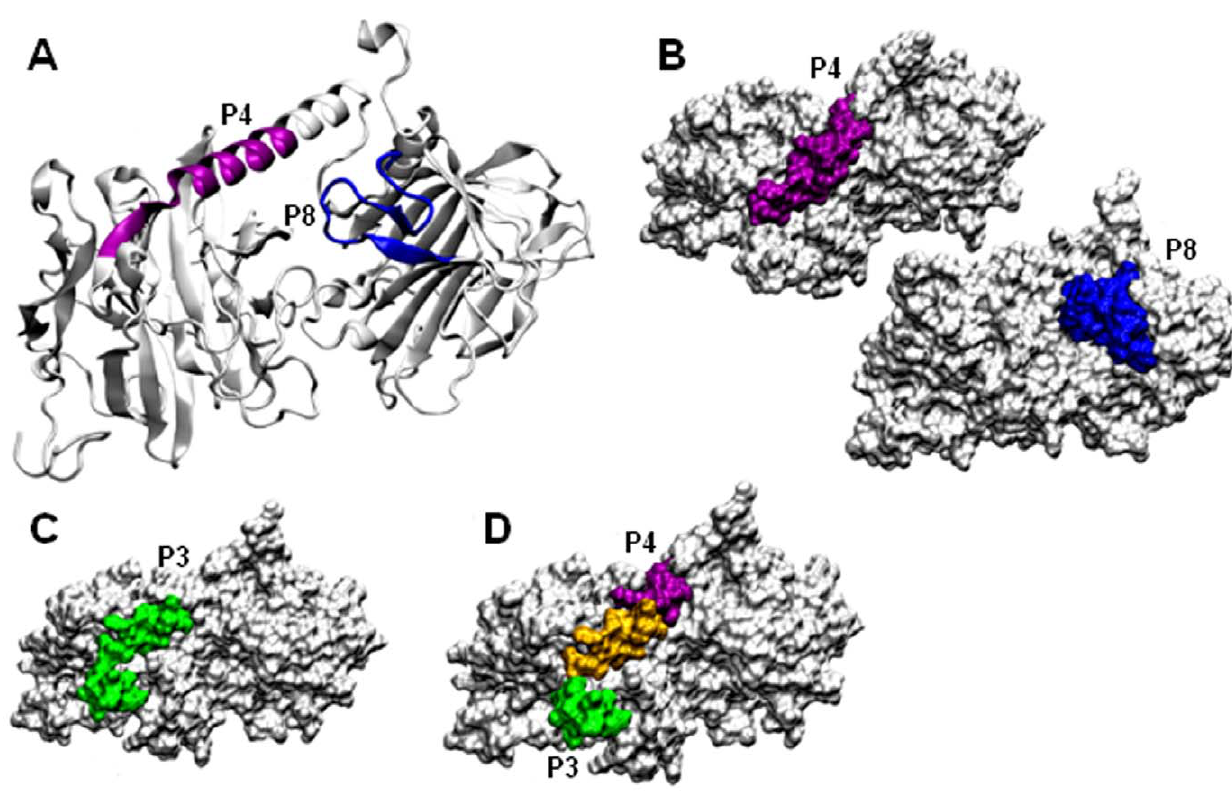
Figure 4. The structural model of gp82. A) Cartoon representation highlighting the cell binding sites P4 (magenta) and P8 (blue). B) Surface representation of sites P4 and P8. C) The epitope for mAb 3F6 (P3) is highlighted (green). D) The portion of P3 that overlaps with P4 is indicated (yellow).